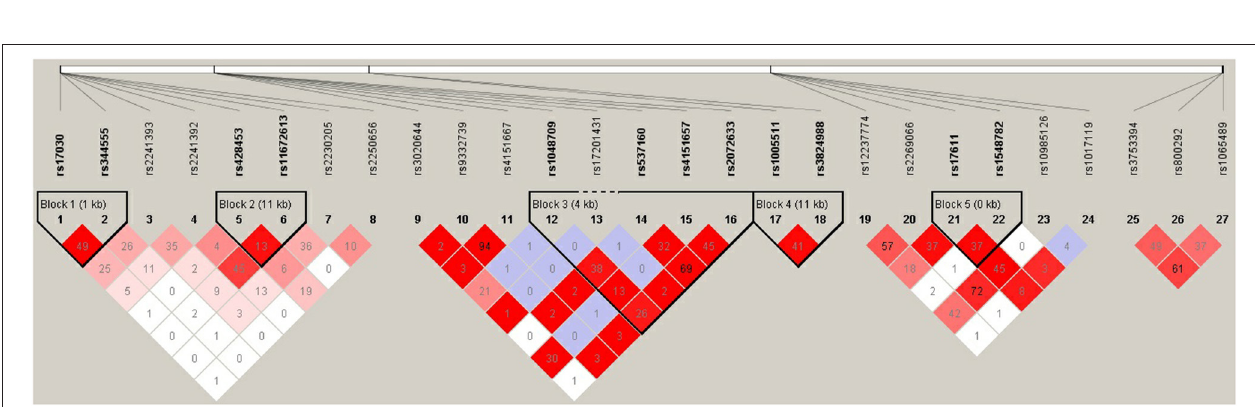
FIGURE 4 | Pairwise LD among 27 SNPs in complement genes across complement system. The haplotype block was defined by the confidence interval method implemented in the Haploview software. The LD ( r 2 ) between any two SNPs is listed in the cross cells.